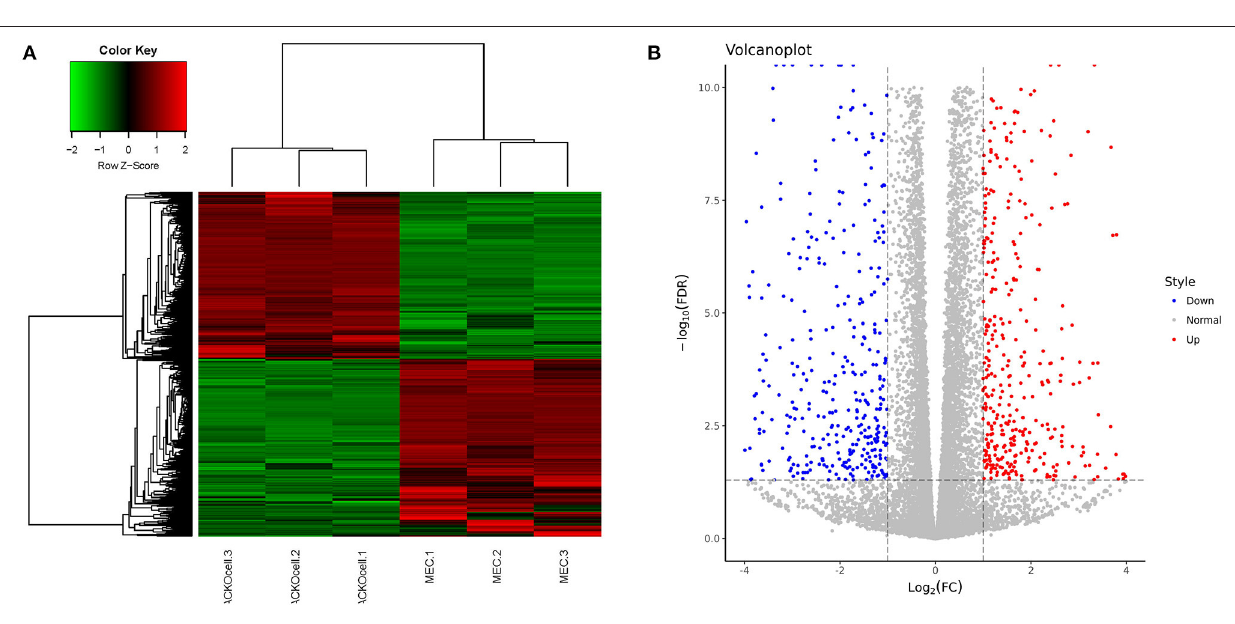
To aid interpretation, the fold change results of relative genes involved in the lipid and fatty acid metabolism pathways are normalized in Table 2 . ACADSB − / − up-regulated seven genes, including acyl-CoA dehydrogenase long-chain ( ACADL ) and acyl-CoA oxidase 2 ( ACOX2 ), according to the findings. ACADSB − / − also caused the down-regulation of ten genes, including acetyl-CoA acetyltransferase 2 ( ACAT2 ) and fatty acid- binding protein 3 ( FABP3 ). The results were also consistent with the RNA-seq results, confirming the RNA seq’s